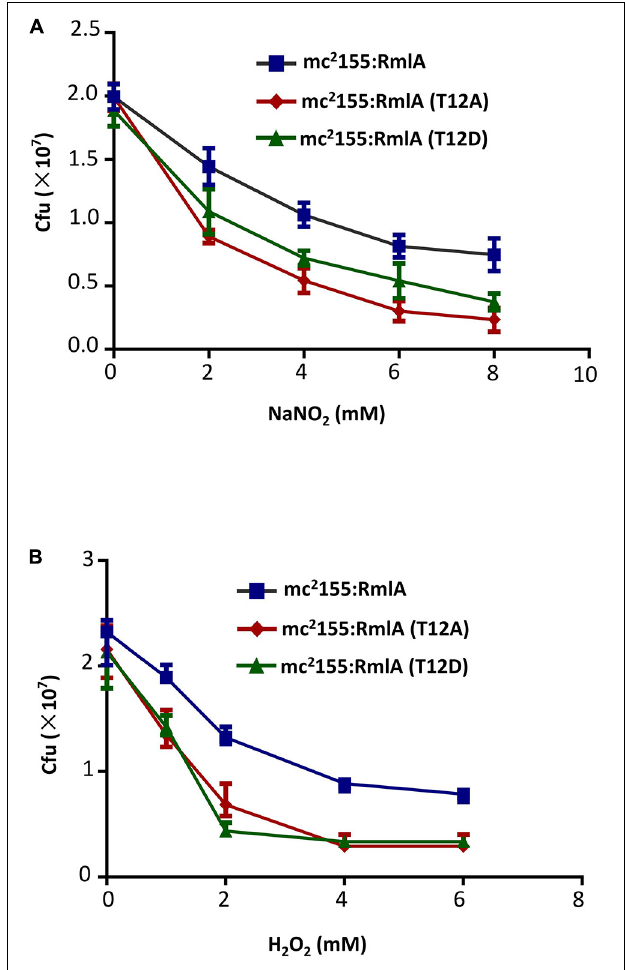
FIGURE 6 | M. smegmatis with RmlA mutants is more sensitive to stress. (A) Survival of strains after 2 days’ exposure to a series of NaNO 2 (0, 2, 4, 6, and 8 mM) at pH 5.5. The experiment was performed in triplicates ( n = 3). Error bars indicate standard error of mean. (B) Survival of strains upon exposure to increasing concentrations of H 2 O 2 (0, 1, 2, 4, and 6 mM) for 12 h. The experiment was performed in triplicates ( n = 3). Error bars indicate standard error of mean.